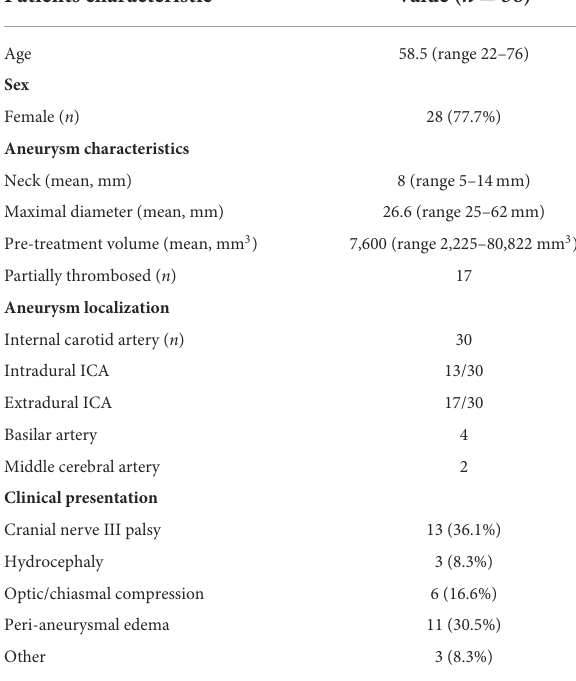
TABLE 1 Baseline patient demographics and clinical presentation of the study population. Patients